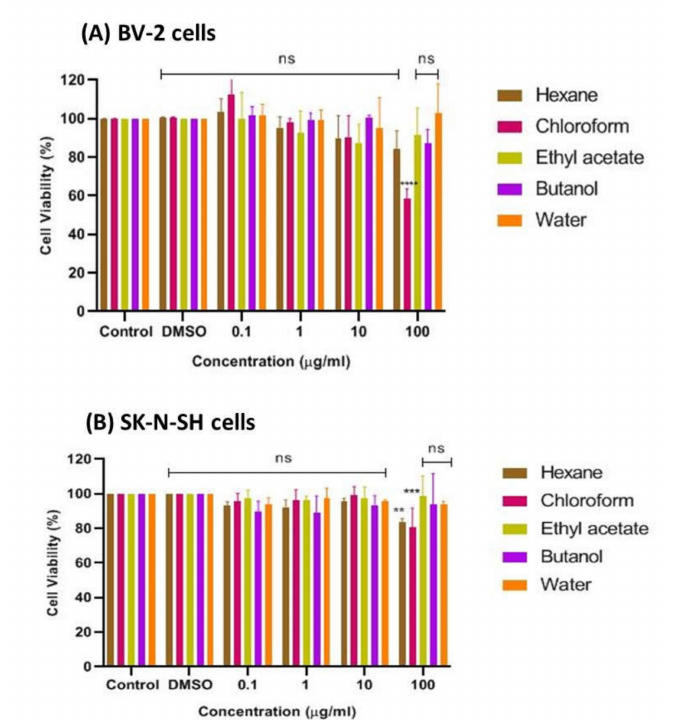
Figure 4. Cytotoxic effect of CTF fractions on viability of ( A ) BV-2 microglial and ( B ) human neuroblas- toma SK-N-SH cells after 24 h. Percent cell viability is expressed as mean ± SD of three independent experiments. The value is statistically significant ** ( p < 0.01), *** ( p < 0.001), and **** ( p < 0.0001) compared to the untreated cells; ns means not significant.